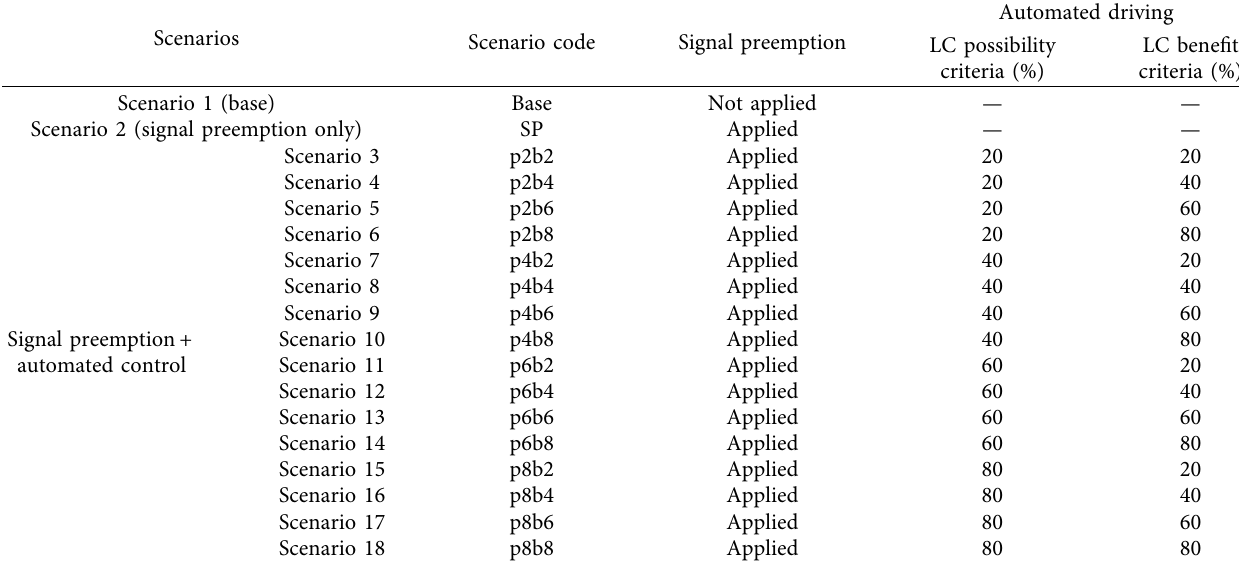
Table 1: Evaluation